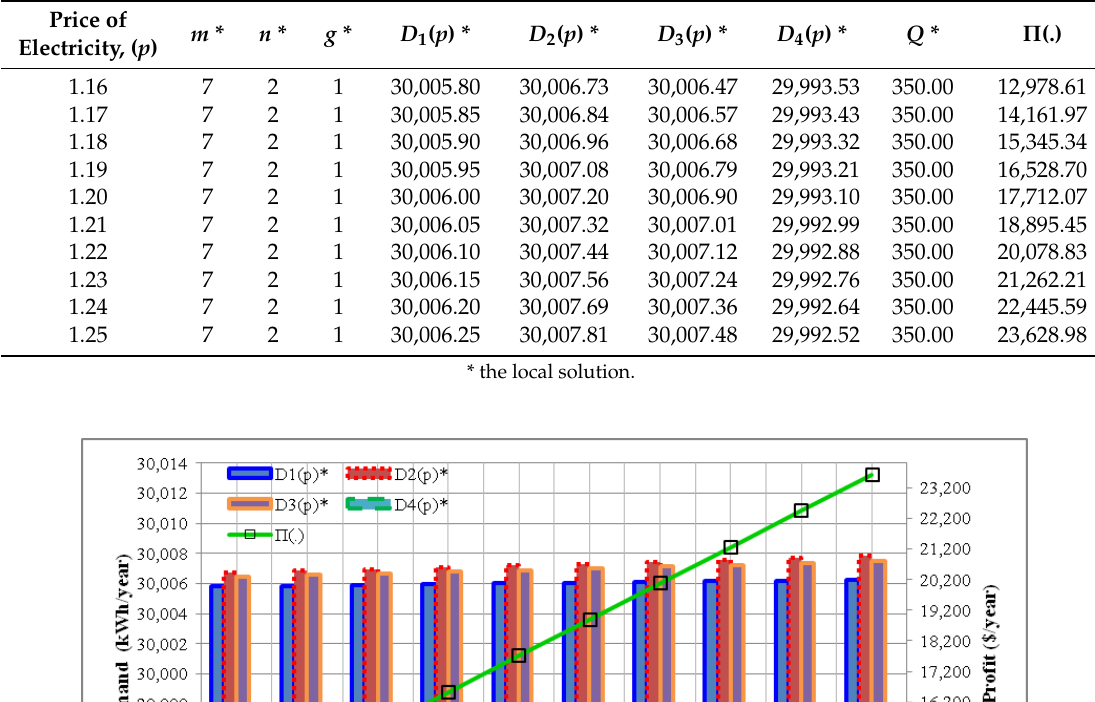
Table 8. Effect of Changes in the Price of Electricity Parameter.